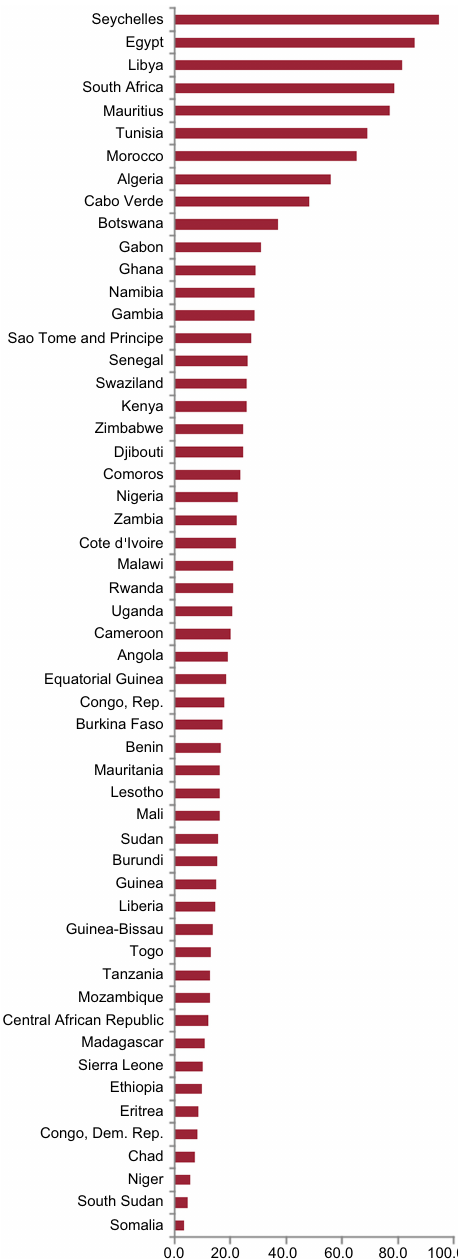
Figure 2. The composite Africa Infrastructure Development Index (AIDI),